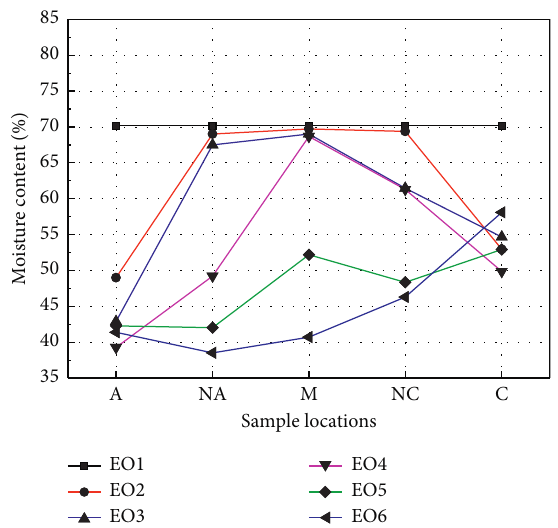
Figure 5: Moisture contents at different